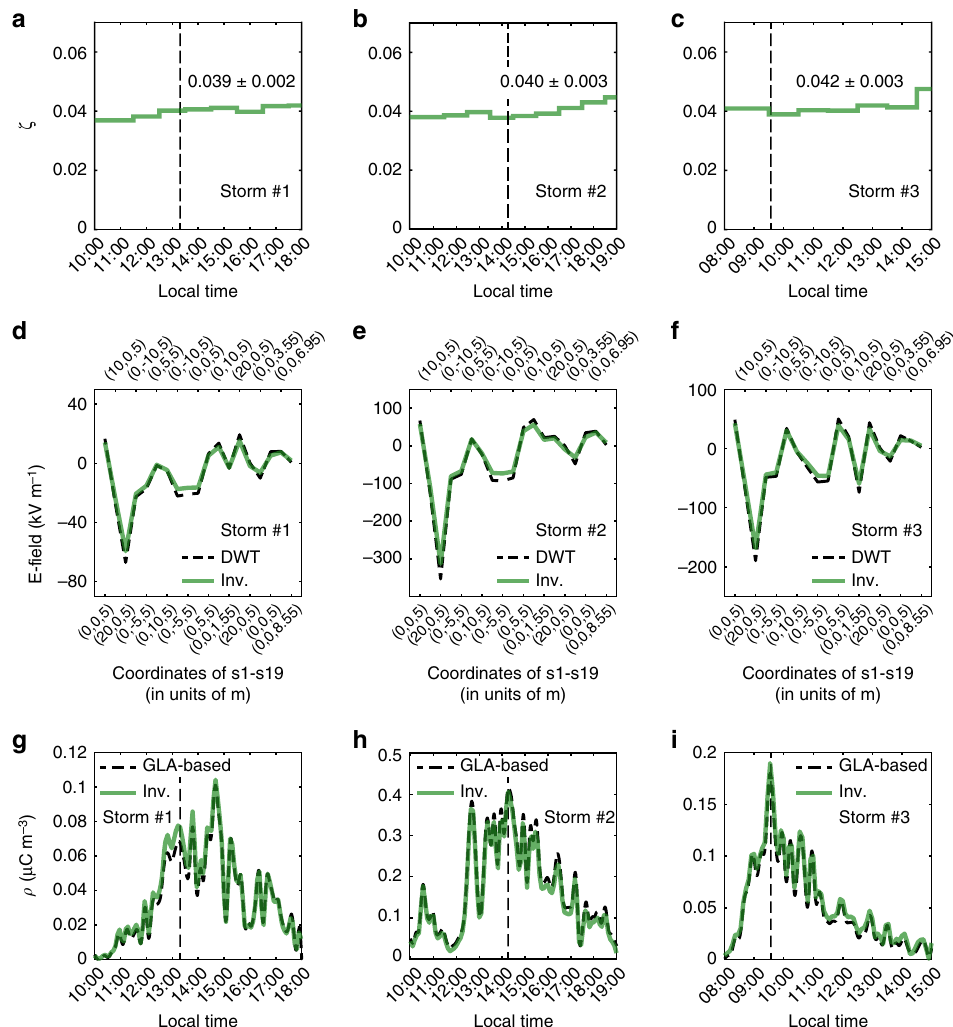
Fig. 4 Veri fi cation of the inversion results. a – c Residual distributions of the inversions for the three observed storms, where the normalized residual ζ are shown by the stairstep lines. d – f Comparisons of the E- fi elds predicted by the inversion model (Inv.) with the discrete wavelet transform (DWT) mean data of sensors s1-s19 at the three instants depicted by the dashed vertical lines in a – c and g – i . The coordinates of the sensors s1-s19 are shown at the top and bottom x -axis. g – i Comparisons of the reconstructed densities ρ ’ s law approximation (GLA)-based densities ρ inv with the Gauss GLA at measurement point